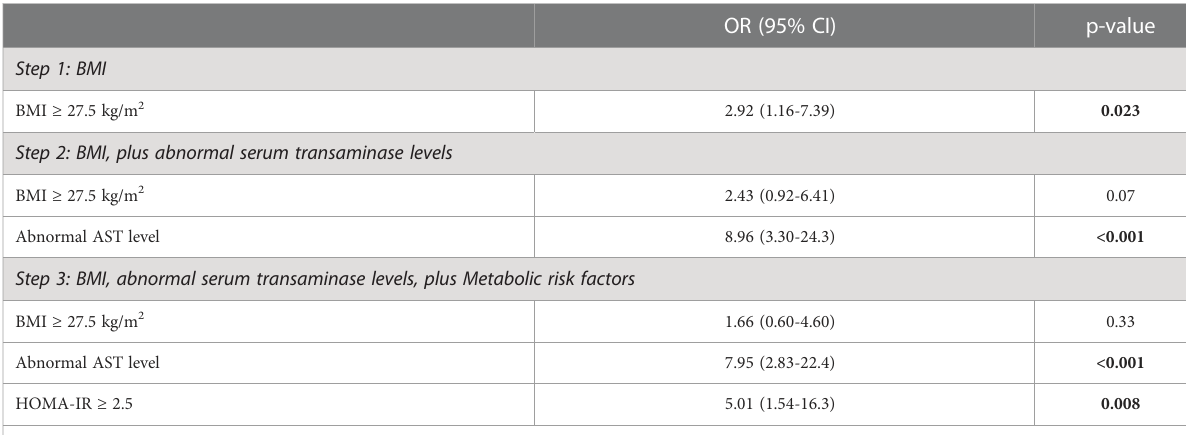
AbnormalserumtransaminaselevelsincludedabnormalALTandASTlevels;Metabolicriskfactorsincludedpresenceofprediabetesbasedonoralglucosetolerancetestand/orHbA1c, and HOMA-IR levels. MAFLD, metabolic dysfunction-associated fatty liver disease; LS, liver stiffness; OR, odds ratio; 95%CI, 95% con fi dence interval; BMI, body mass index; AST, aspartate aminotransferase; HOMA-IR, homeostatic model assessment of insulin resistance; ALT, alanine aminotransferase; OGTT, oral glucose tolerance test; HbA1c, glycated haemoglobin.